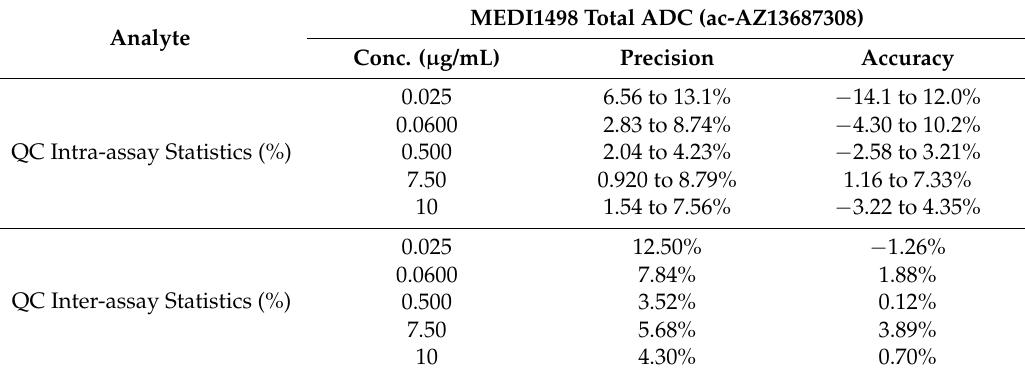
Table 6. Total ADC (MEDI1498) Precision and